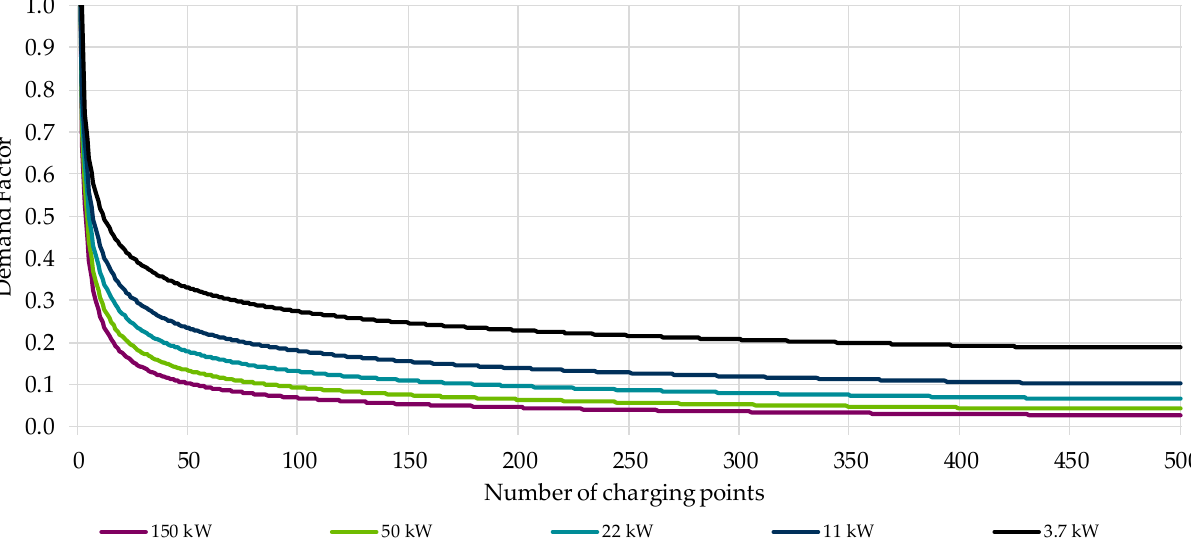
Figure 2. Demand factors for five dominant charging powers for up to 500 charging points based on [50].